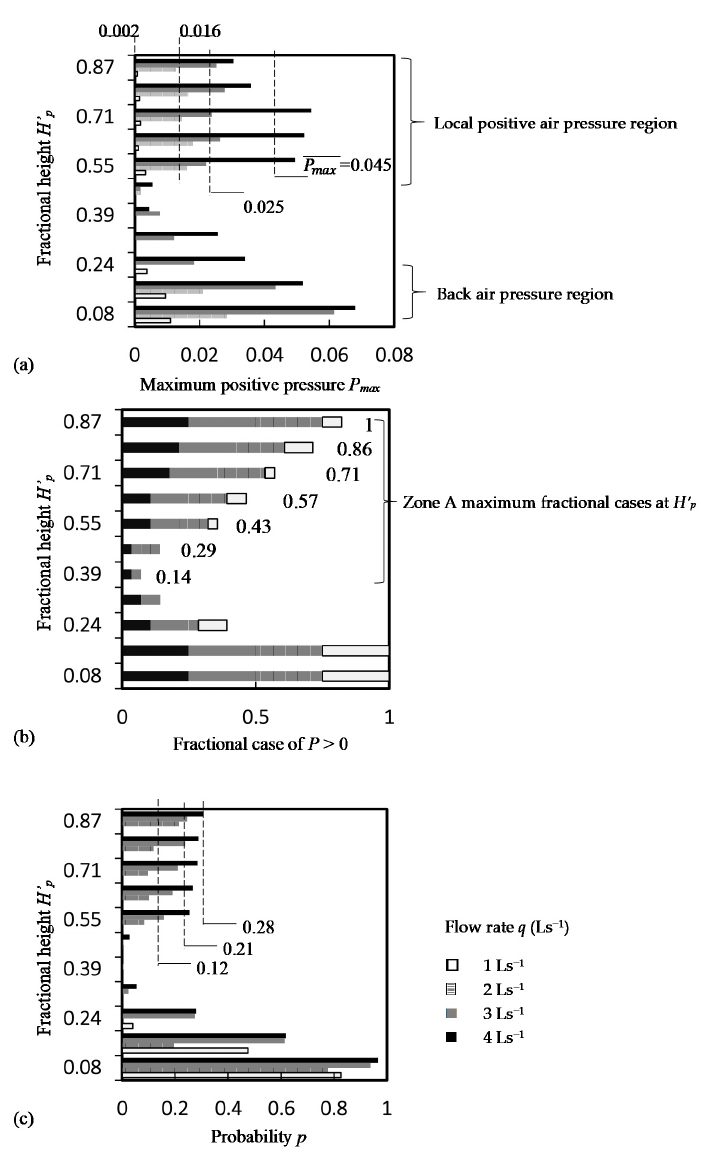
Figure 5. Positive air pressure occurrence profiles along with a drainage stack ( H = 38 m). ( a ) Maxi- mum positive pressure (m wg.); ( b ) fractional cases having positive pressure; ( c ) fractional discharging time having positive pressure in a case.